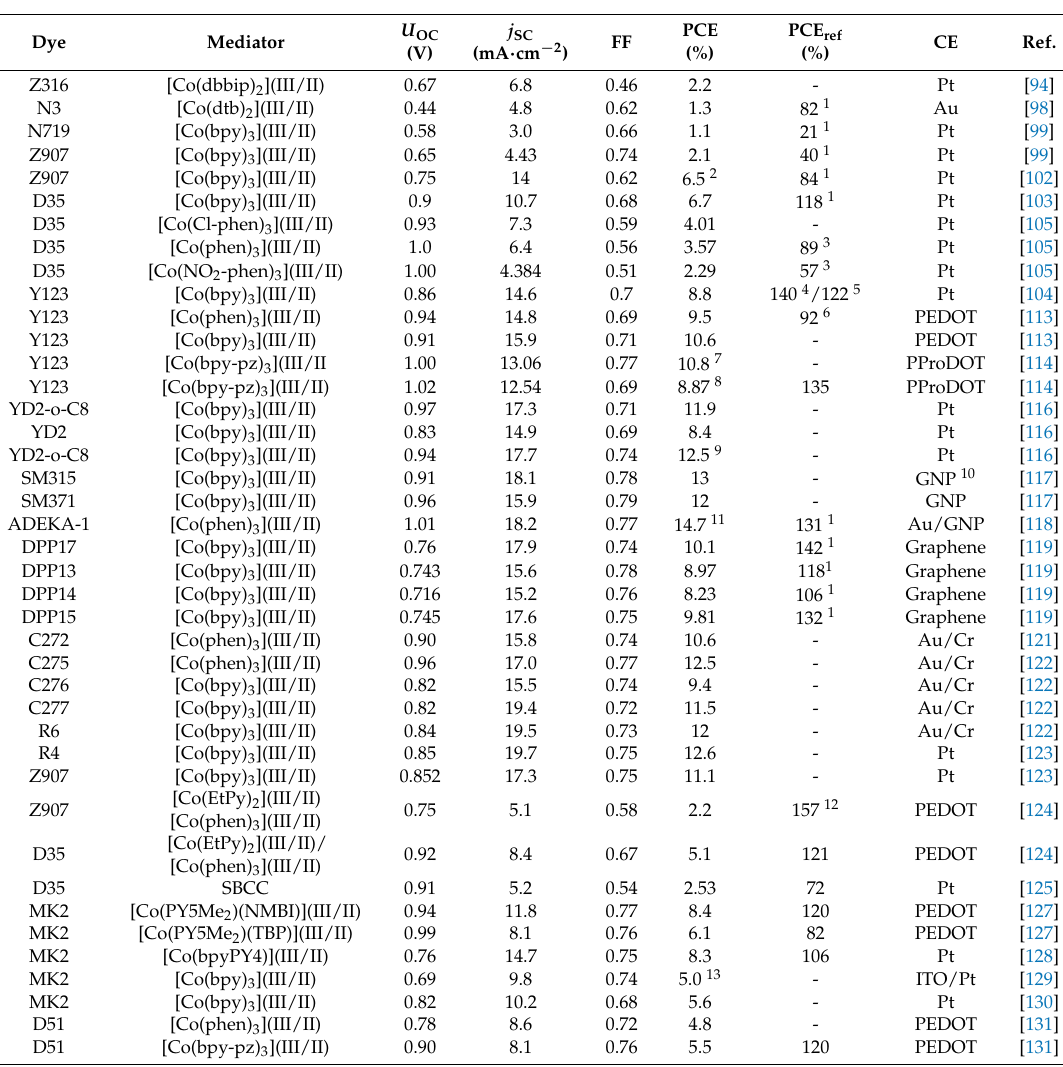
Table 1. Photovoltaic data for the devices employing cobalt redox mediators. The relative efficiency values power conversion efficiency (PCE) rel are calculated as PCE rel = PCE/PCE ref where PCE ref is the PCE of a cell with a reference